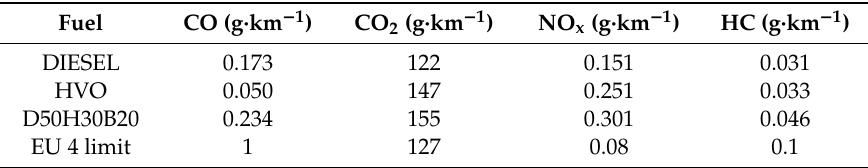
Table 8. Emission parameters under NEDC driving cycle.